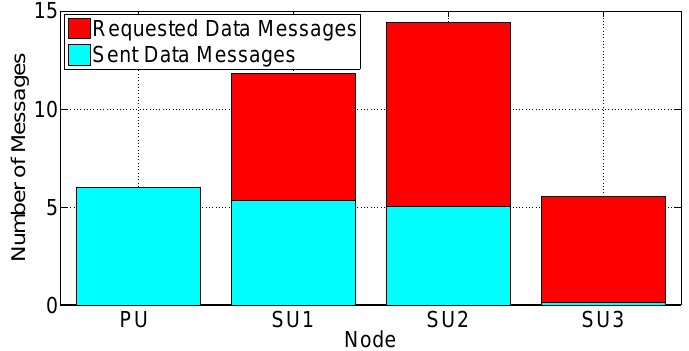
Figure 13. Average number of DATA chunks requested and average number of DATA messages sent following a REQUEST , in Scenario 1.